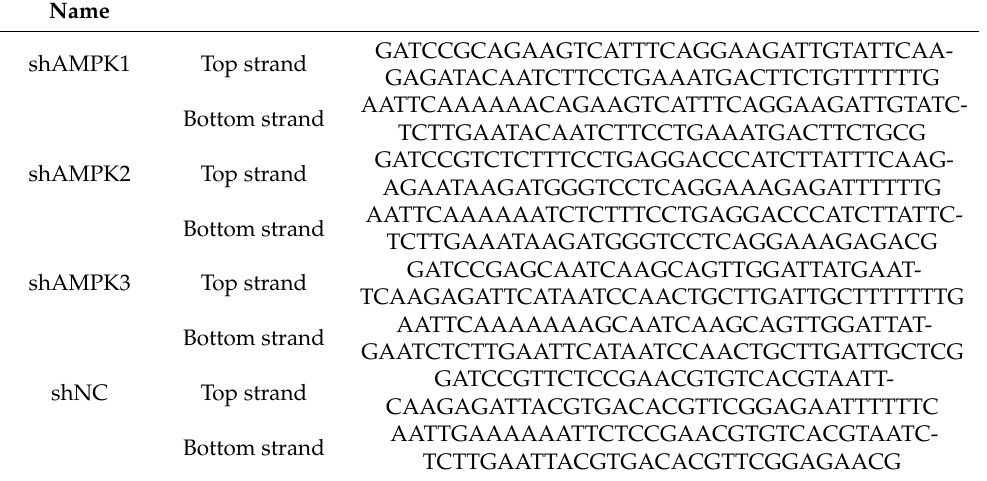
Table 3. Sequences of short hairpin RNA used for lentiviral shRNA